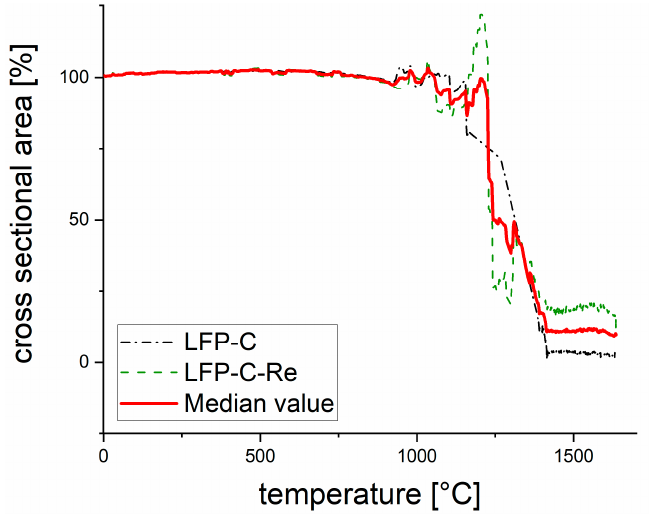
Figure 7. Results of the heating microscope of LFP-C: trend of the cross-sectional area of the experiments LFP-C and LFP-C-Re during heating and the median value of the both graphics.